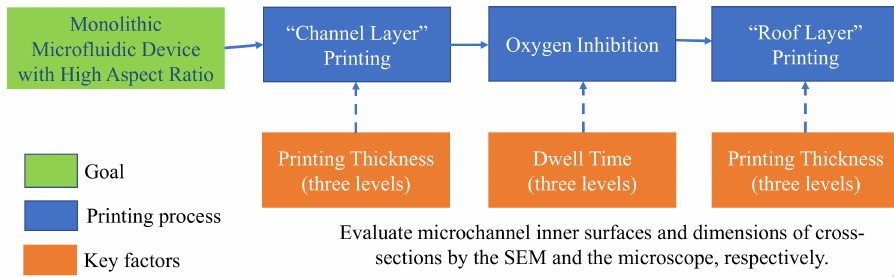
Figure 3. Flow chart showing the overall study process for manufacturing monolithic microfluidic devices including three major factors that each have three